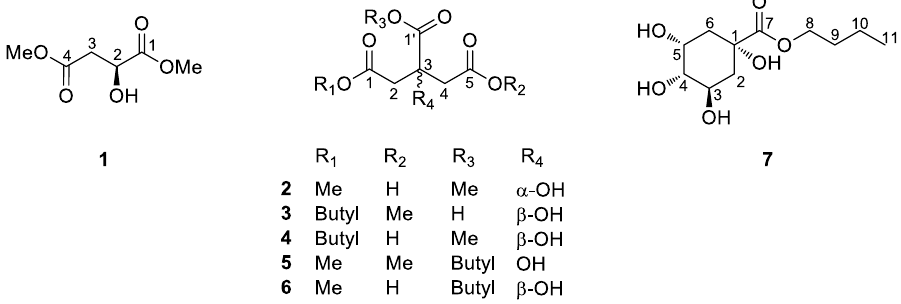
Figure 1. Chemical structure of compounds 1–7 .